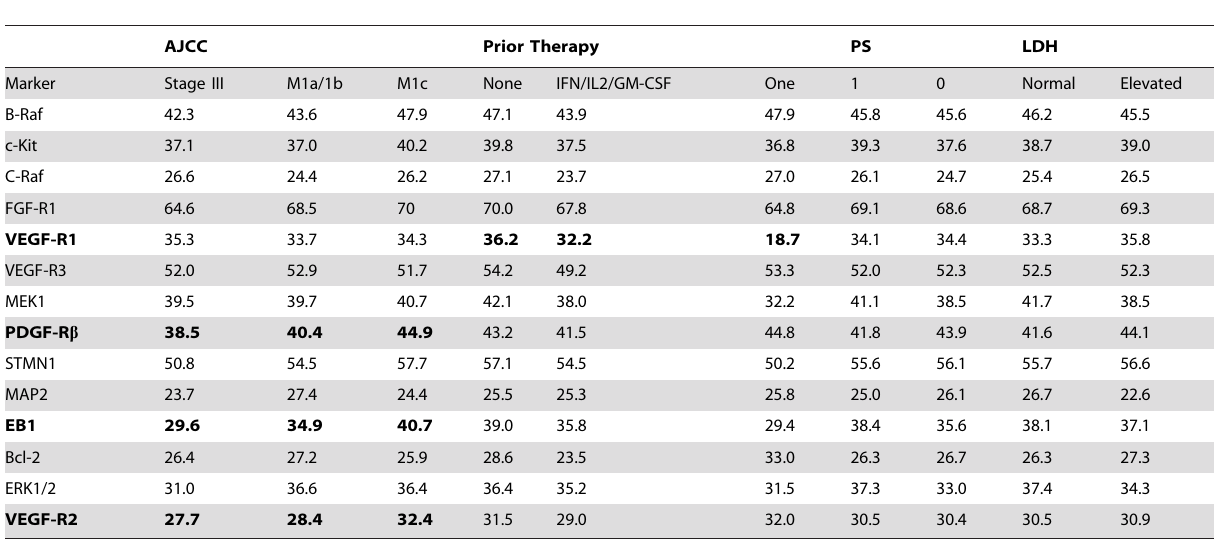
Table 2. Average level of expression for each biomarker (continuous AQUA scores) by clinical